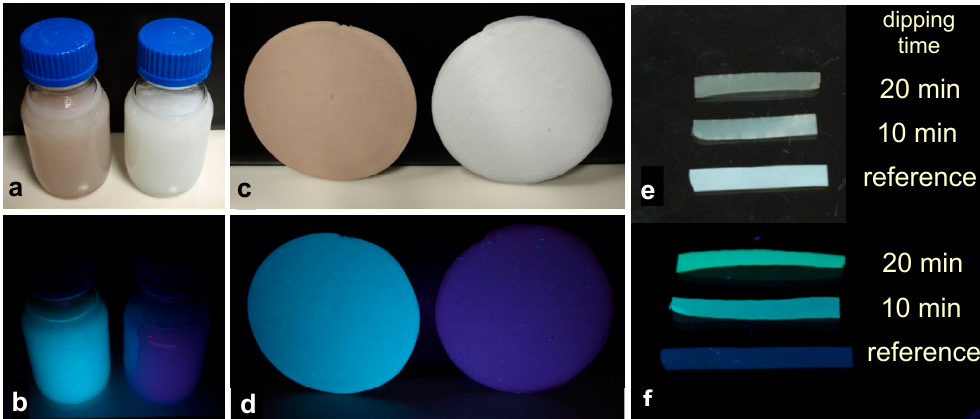
fe Figure 6. Aqueous suspensions of TEMPO-mediated oxidation and nanofibrillation of bacterial cellulose (TOBC) nanofibrils covalently equipped with GEA-type CDs ( a , b ) and nanopaper prepared therefrom ( c , d ) at daylight ( a , c ) and UV excitation (the CD-free reference material is shown in each of the pictures a-d on the right). Pictures of prefabricated TOBC nanopaper subjected to EDC/NHS-mediated dip-grafting of GEA-type CDs (10 or 20 min) taken at daylight ( e ) or under UV light ( f ). FEG-SEM images of TOBC/CD hybrid nanopaper formed after EDC/NHS-mediated grafting of GEA-type CDs onto TOBC fibrils in dispersion state revealed a dense, partly interwoven structure of entangled microfibrils (Figure 7a). At higher magnification, the typical void structure of